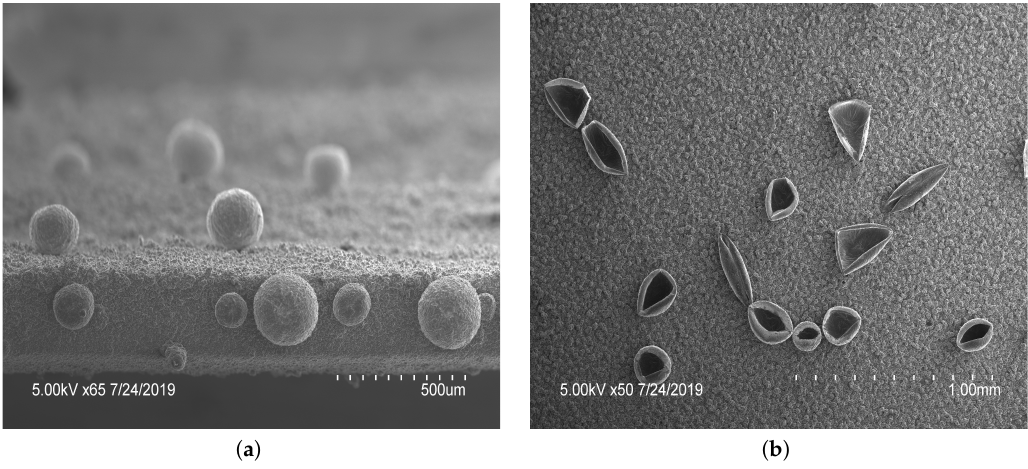
Figure 2. Scanning electron microscopy images of polypyrrole (PPy) films with features: PPy microstructures formed by potential cycling 2 cycles of 0–1.2 V, followed by 2 cycles of − 1.6– ( − 0.6 ) V and ( a ) 7 or ( b ) 2 cycles between 0 and 1.2 V. The number of cycles in the last stage of polymerization dictated the open or closed